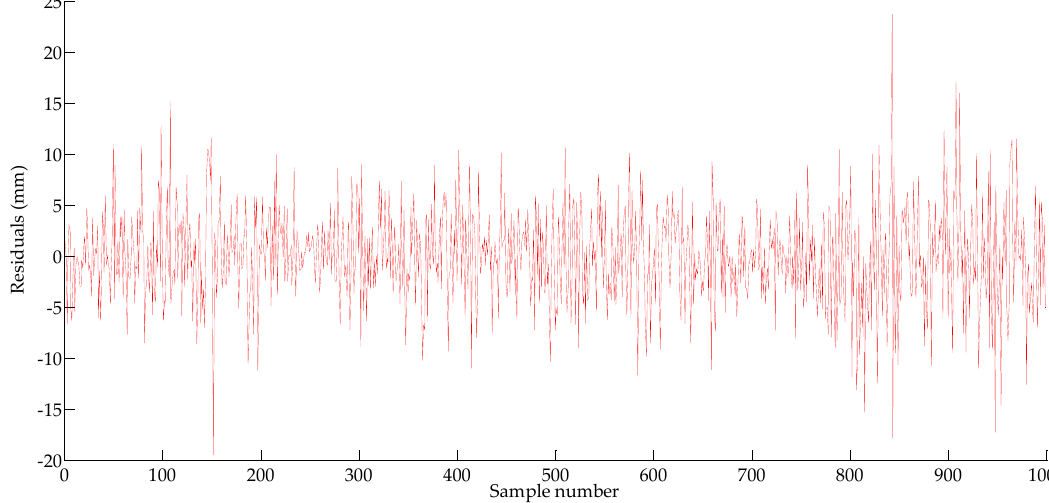
Figure 10. The residual error of autoregressive integrated moving average (ARIMA).